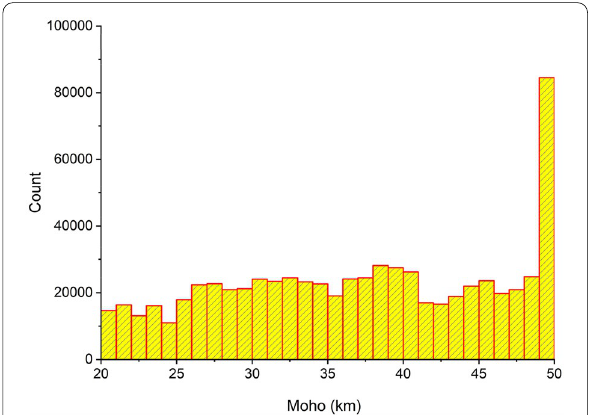
Fig. 7 Frequency distribution of Moho depth values in the study